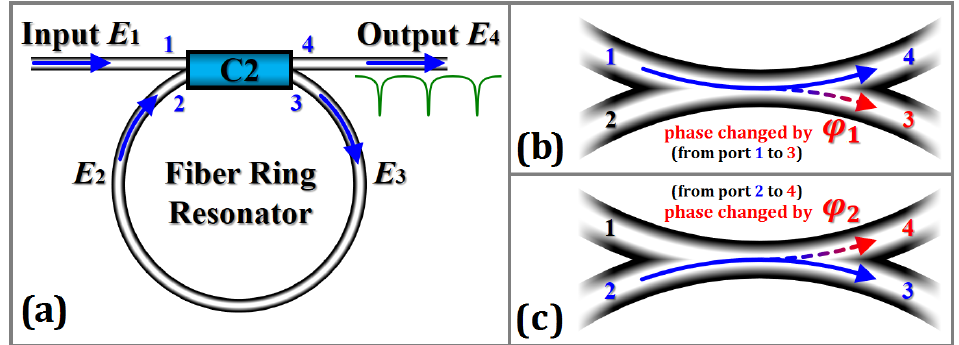
Figure 2. ( a ) Transmission process of one of the light waves in FRR. ( b ) The phase is changed by φ 1 from port 1 to 3. ( c ) The phase is changed by φ 2 from port 2 to 4. ( E i : the optical field complex amplitude of port i is denoted).